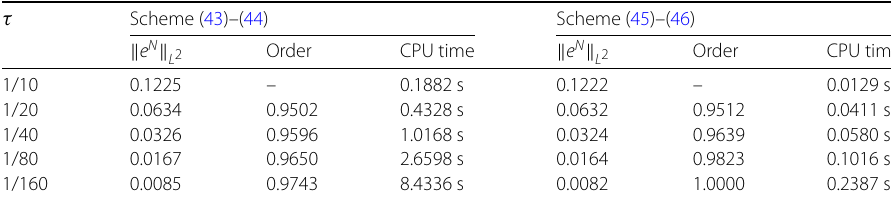
Table 1 Errors and convergence orders of scheme (43)–(44) and scheme (45)–(46) in temporal direction (Example 1)